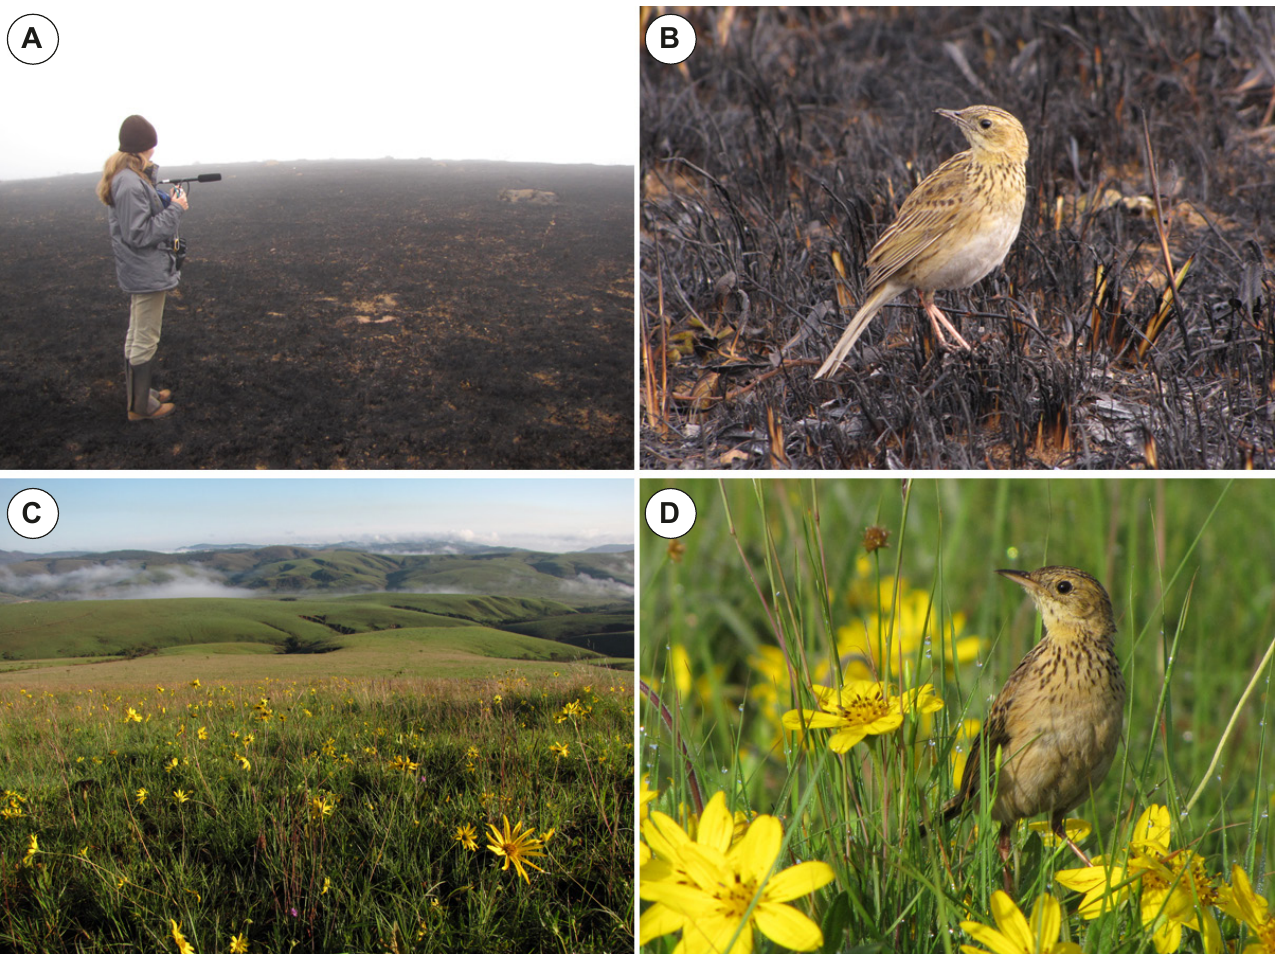
Figure 2. Anthus nattereri Photographic records of the Ochre-breasted Pipit and its habitat in the Quadrilátero Ferrífero region, Minas Gerais state, Brazil: A and B - burnt “campo limpo” grassland where the species was recorded on September 2010; C and D - same area on November 2010, with the grassland regenerated from the fire. Photos: Luiz Gabriel